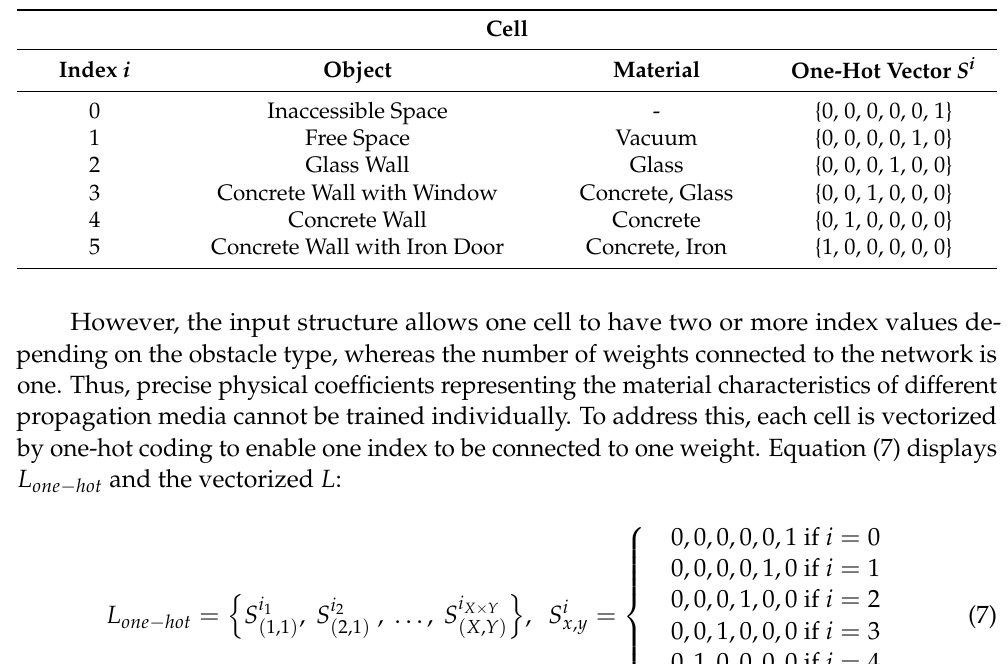
Table 2. Cell properties designed for obstacle